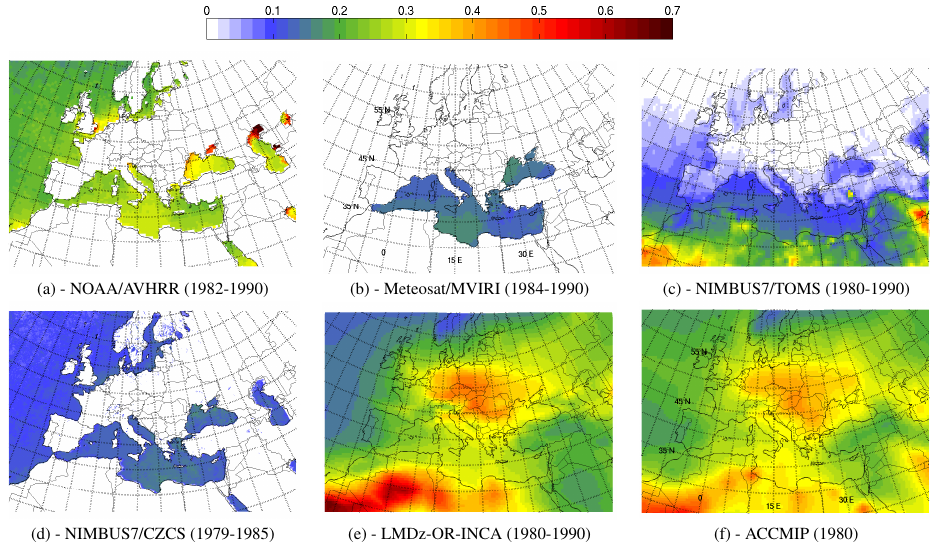
Fig. 12. Mean Aerosol Optical Depth (AOD) at 550 nm from different products over the Mediterranean basin between 1979 and 1990. Table 5. AOD differences between 2000 and 1980 in the ACCMIP models. Region CICERO GFDL GISS GISS-TOMAS HadGEM2 LMDz-OR-INCA NCAR-3.5 NCAR-5.1 Mean CALIOP region N ◦ Limits Maghreb 1 AO, MS and 11 ◦ E Europe − 0.14 − 0.14 − Libya-Egypt 11 ◦ E, MS and RS Red Sea